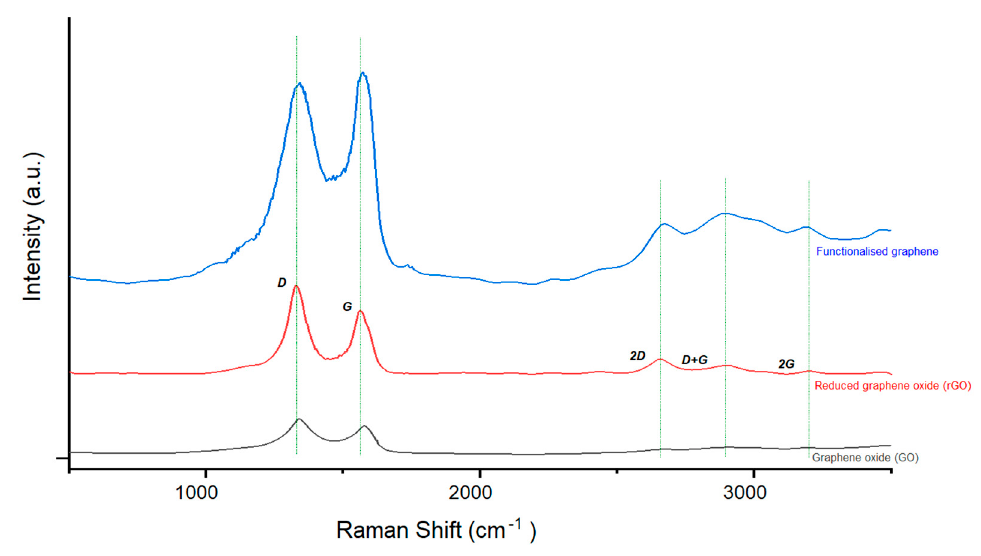
Figure 3. Raman spectra of graphene oxide, reduced graphene oxide and indium-functionalized rGO.